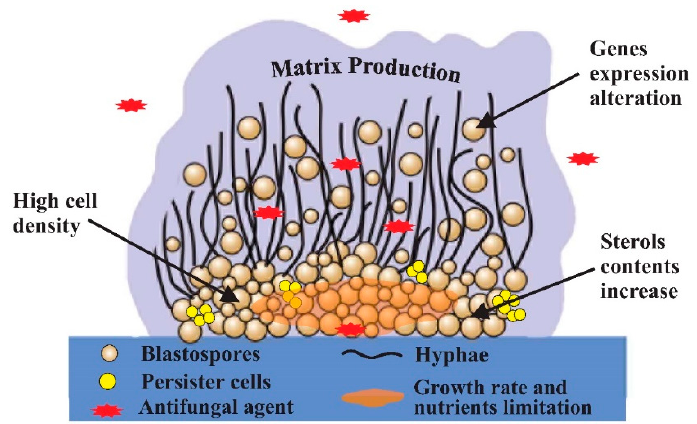
Figure 1. General scheme of the mechanisms described as involved on Candida species biofilm resistance.